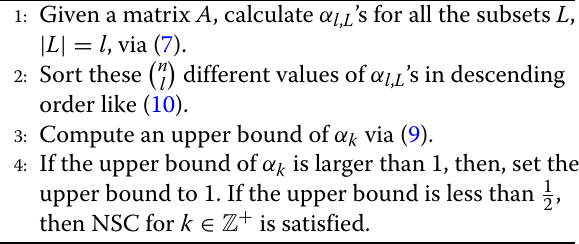
Algorithm 1: Pick- l -element algorithm, 1 ≤ l < k for computing an upper bound of α